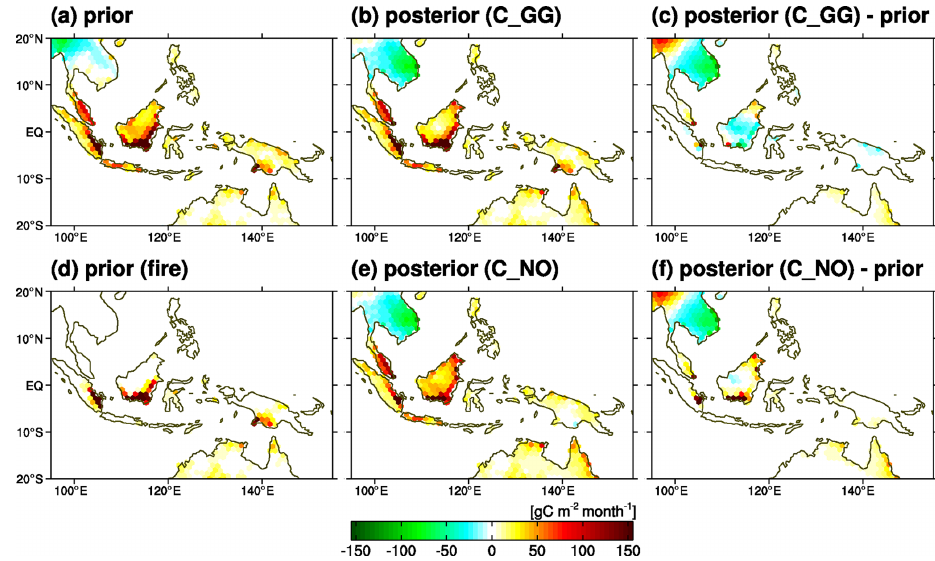
Figure 9. Same as Fig. 8, but for October 2015.